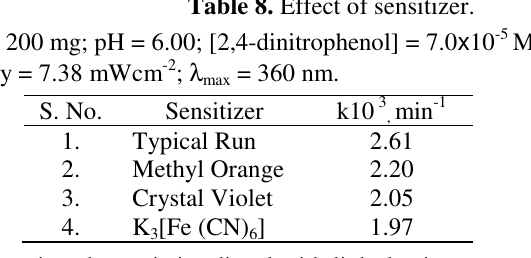
Table 8. Effect of